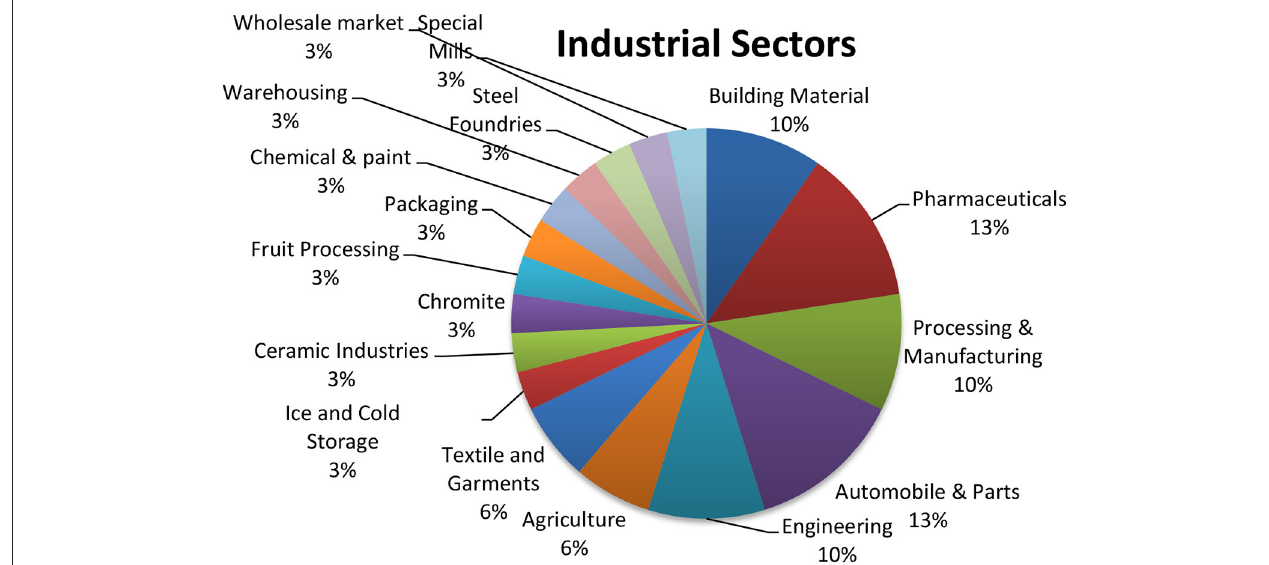
FIGURE 12 | Expected industries SEZs in Pakistan (consult Appendix B for detail).